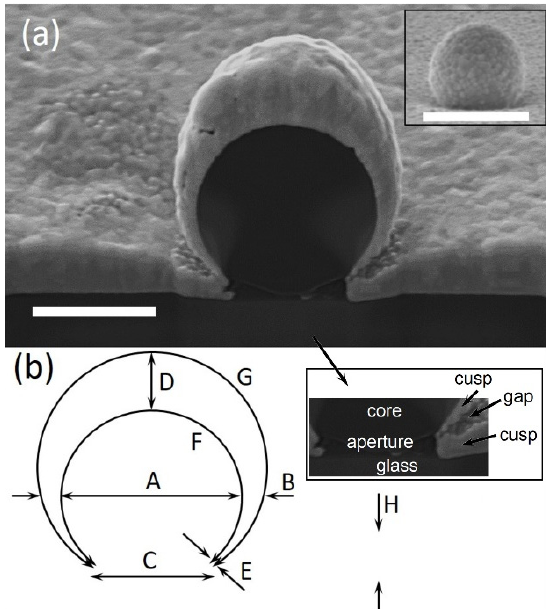
Figure 4. ( a ) Scanning electron micrograph of a vertical bisecting cross-section of a MSPRS made with a 780 ± 6 nm polystyrene sphere covered with a 170 nm Au film. Micrograph was corrected for 54° vertical tilt. Scale bar: 500 nm; ( top insert ) Scanning electron micrograph of a whole MSPRS, side view. Micrograph is tilt-corrected for 82° vertical tilt. Scale bar: 1 µm; ( b ) Template showing measurement locations; ( bottom insert ) Arrows point at aperture architecture details with labels.